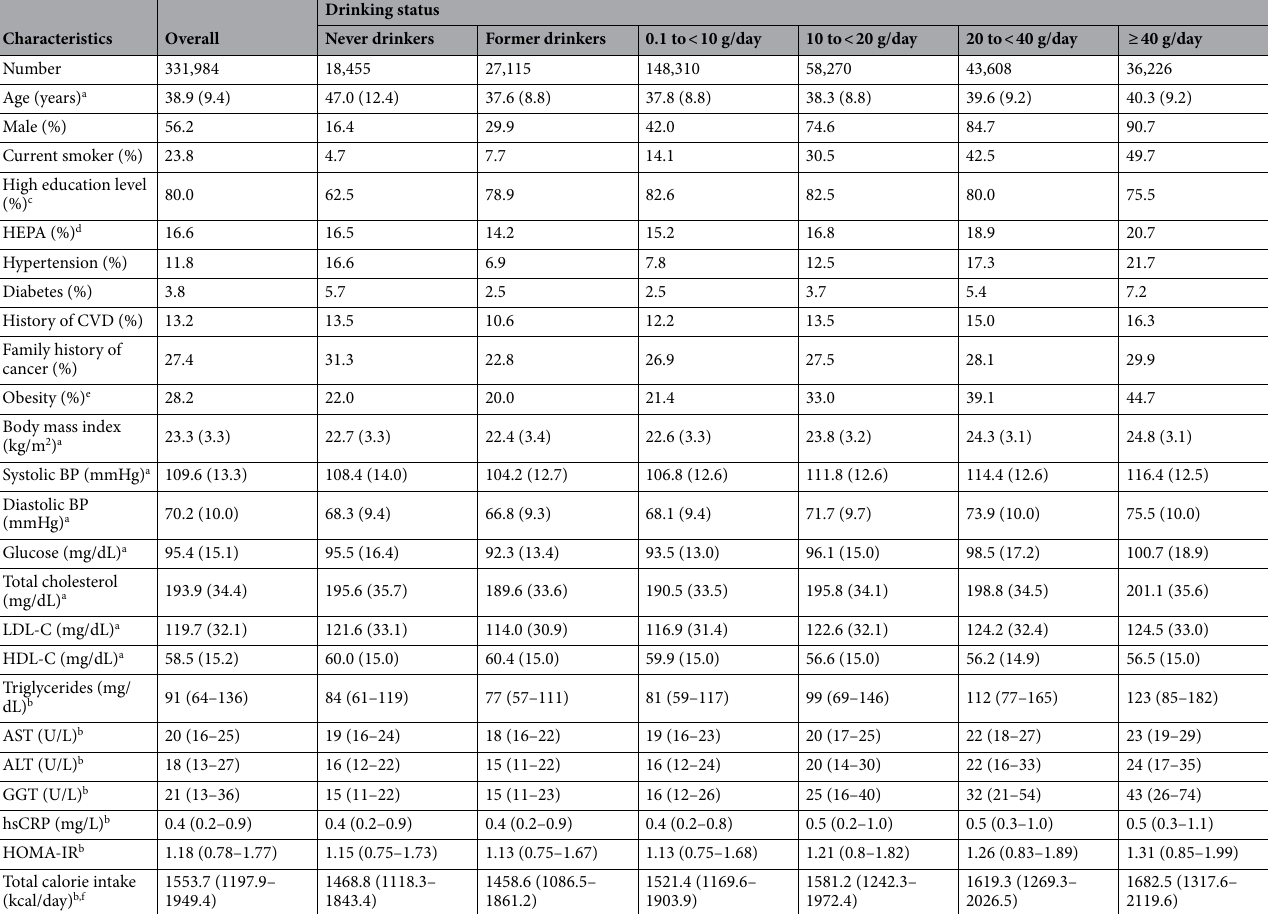
Table 1. Baseline characteristics according to drinking status (n = 331,984). Data are expressed as a mean (standard deviation), b median (interquartile range), or percentage. c ≥ College graduate, d Defined as physical activity that meets either of two criteria: (i) vigorous-intensity activity on three or more days per week accumulating ≥ 1500 metabolic equivalent (MET) min/week; or (ii) seven days of any combination of walking, moderate-intensity, or vigorous-intensity activities achieving at least 3000 MET-min/week; e body mass index ≥ 25 kg/m 2 . f Among 227,464 participants with plausible estimated energy intake levels (within three standard deviations of the log-transformed mean energy intake). ALT alanine aminotransferase, AST aspartate aminotransferase, BP blood pressure, CVD cardiovascular disease, GGT gamma-glutamyl transpeptidase, HDL-C high-density lipoprotein-cholesterol, HEPA health-enhancing physically active, hsCRP high sensitivity C-reactive protein, HOMA-IR homeostasis model assessment of insulin resistance, LDL-C low-density lipoprotein